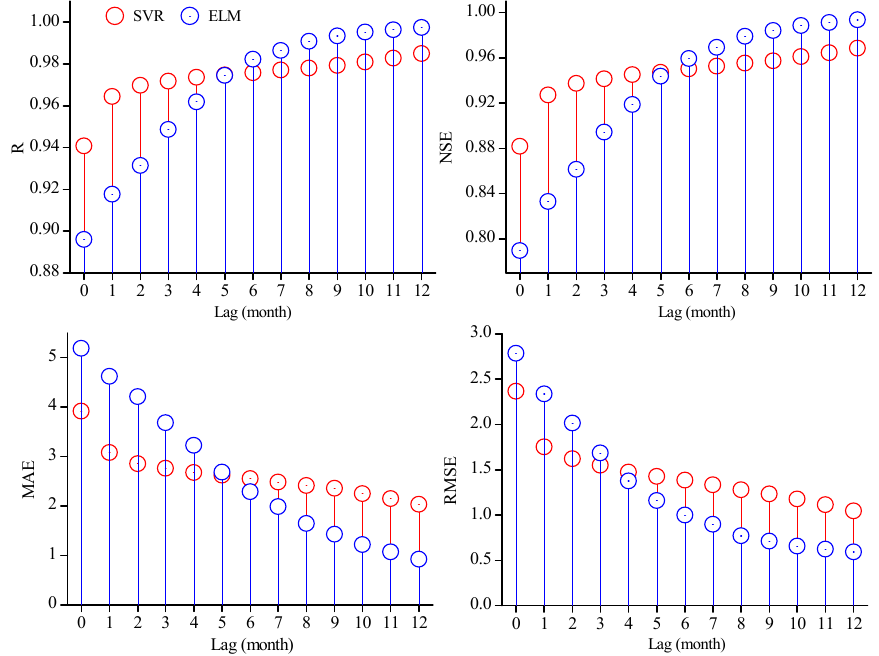
Figure 3. Performances of the Support Vector Regression (SVR) and Extreme Learning Machine (ELM) for the determination of the climate–hydrological relationship derived from the observed precipitation, temperature, and streamflow with time